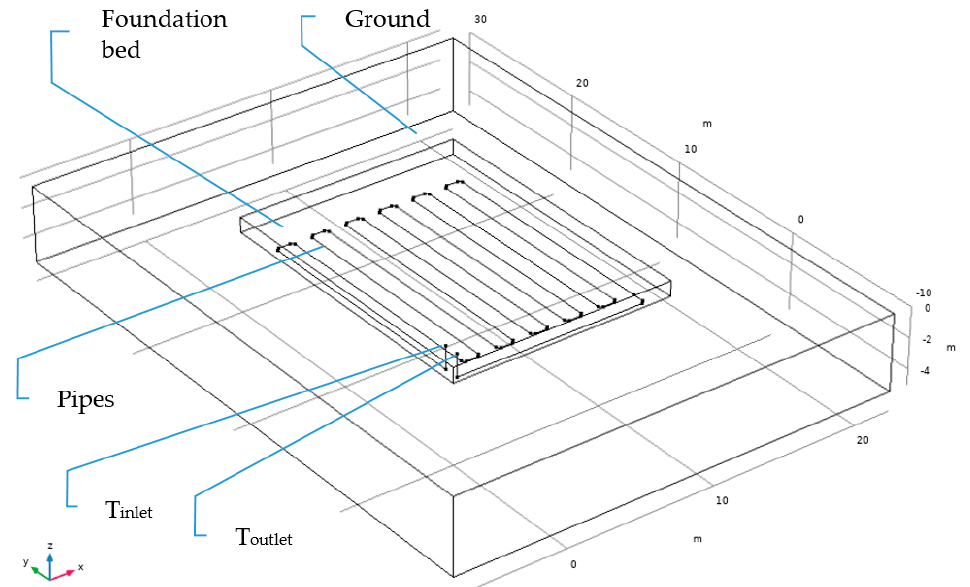
Figure 5. Foundation bed ground heat exchanger (GHE) geometry. Table 4. Foundation bed dimensional model characteristics.